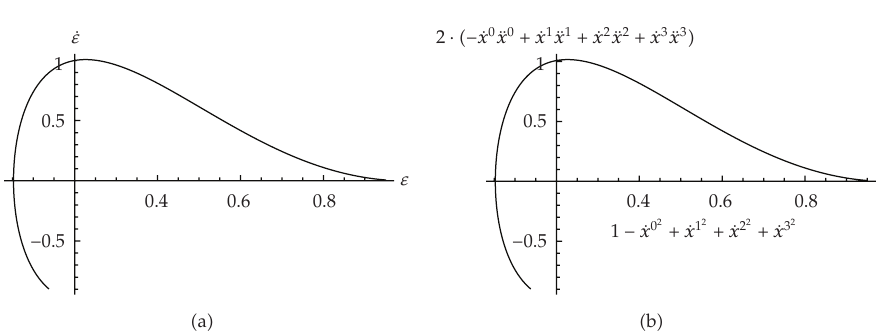
Figure 2: (cid:6) a (cid:7) Second set, the autonomous equation trajectory. (cid:6) b (cid:7) Second set, the orbit equation trajectory.